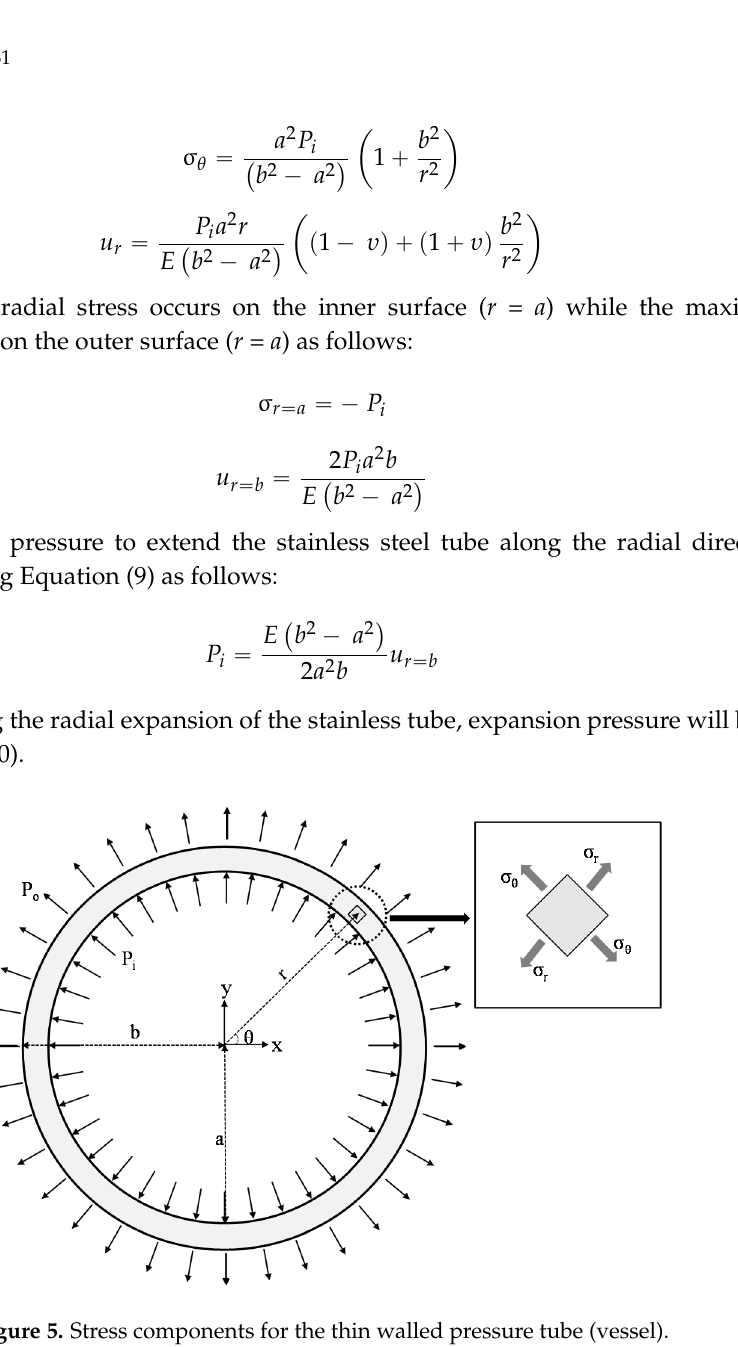
Figure 5. Stress components for the thin walled pressure tube (vessel).